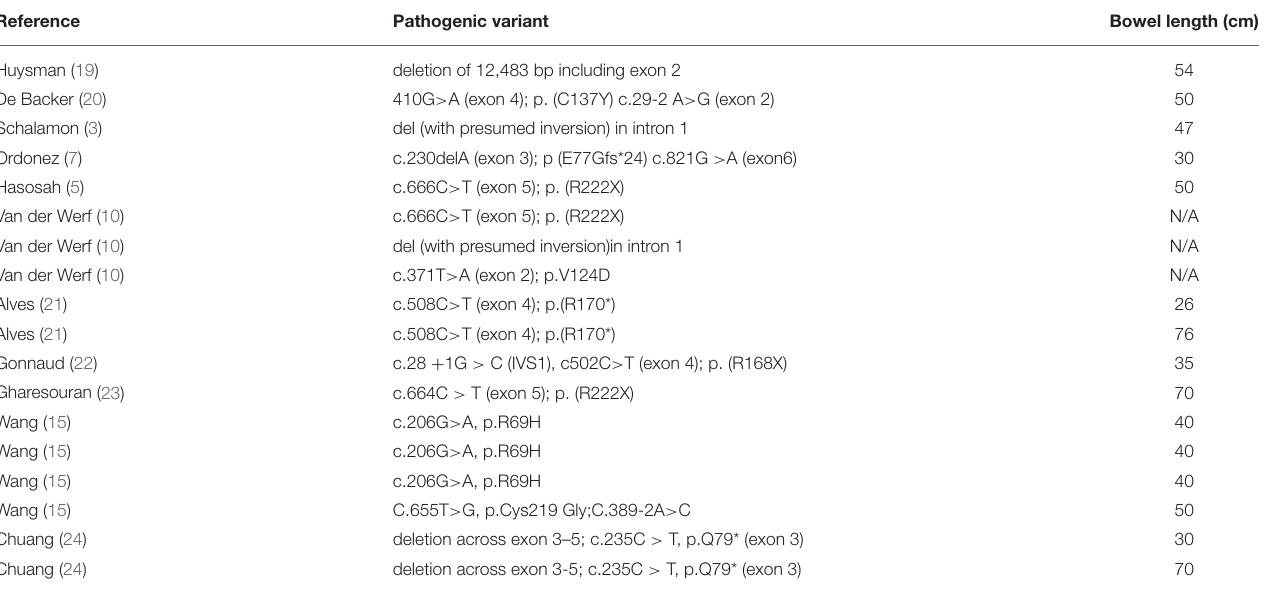
TABLE 1 | Literature review of CLMP gene variant in patients with